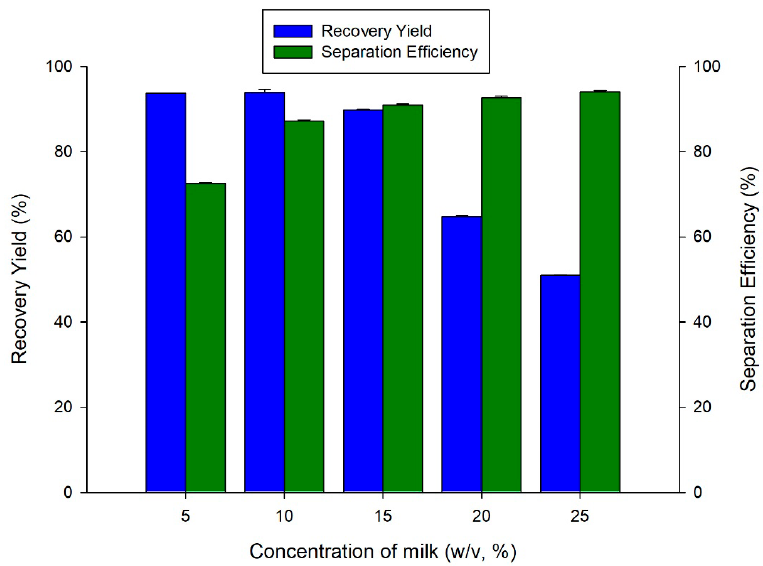
Figure 6. The e ff ect of di ff erent concentrations of milk on the protein recovery yield and separation Figure 6. The effect of different concentrations of milk on the protein recovery yield and separation e ffi ciency utilizing LBF efficiency utilizing LBF system.